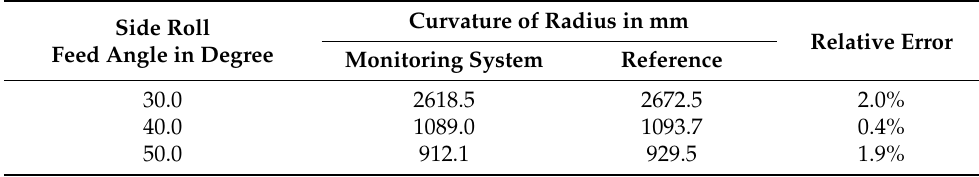
Table 2. Testing of the accuracy of the monitoring system on simulation data. Side